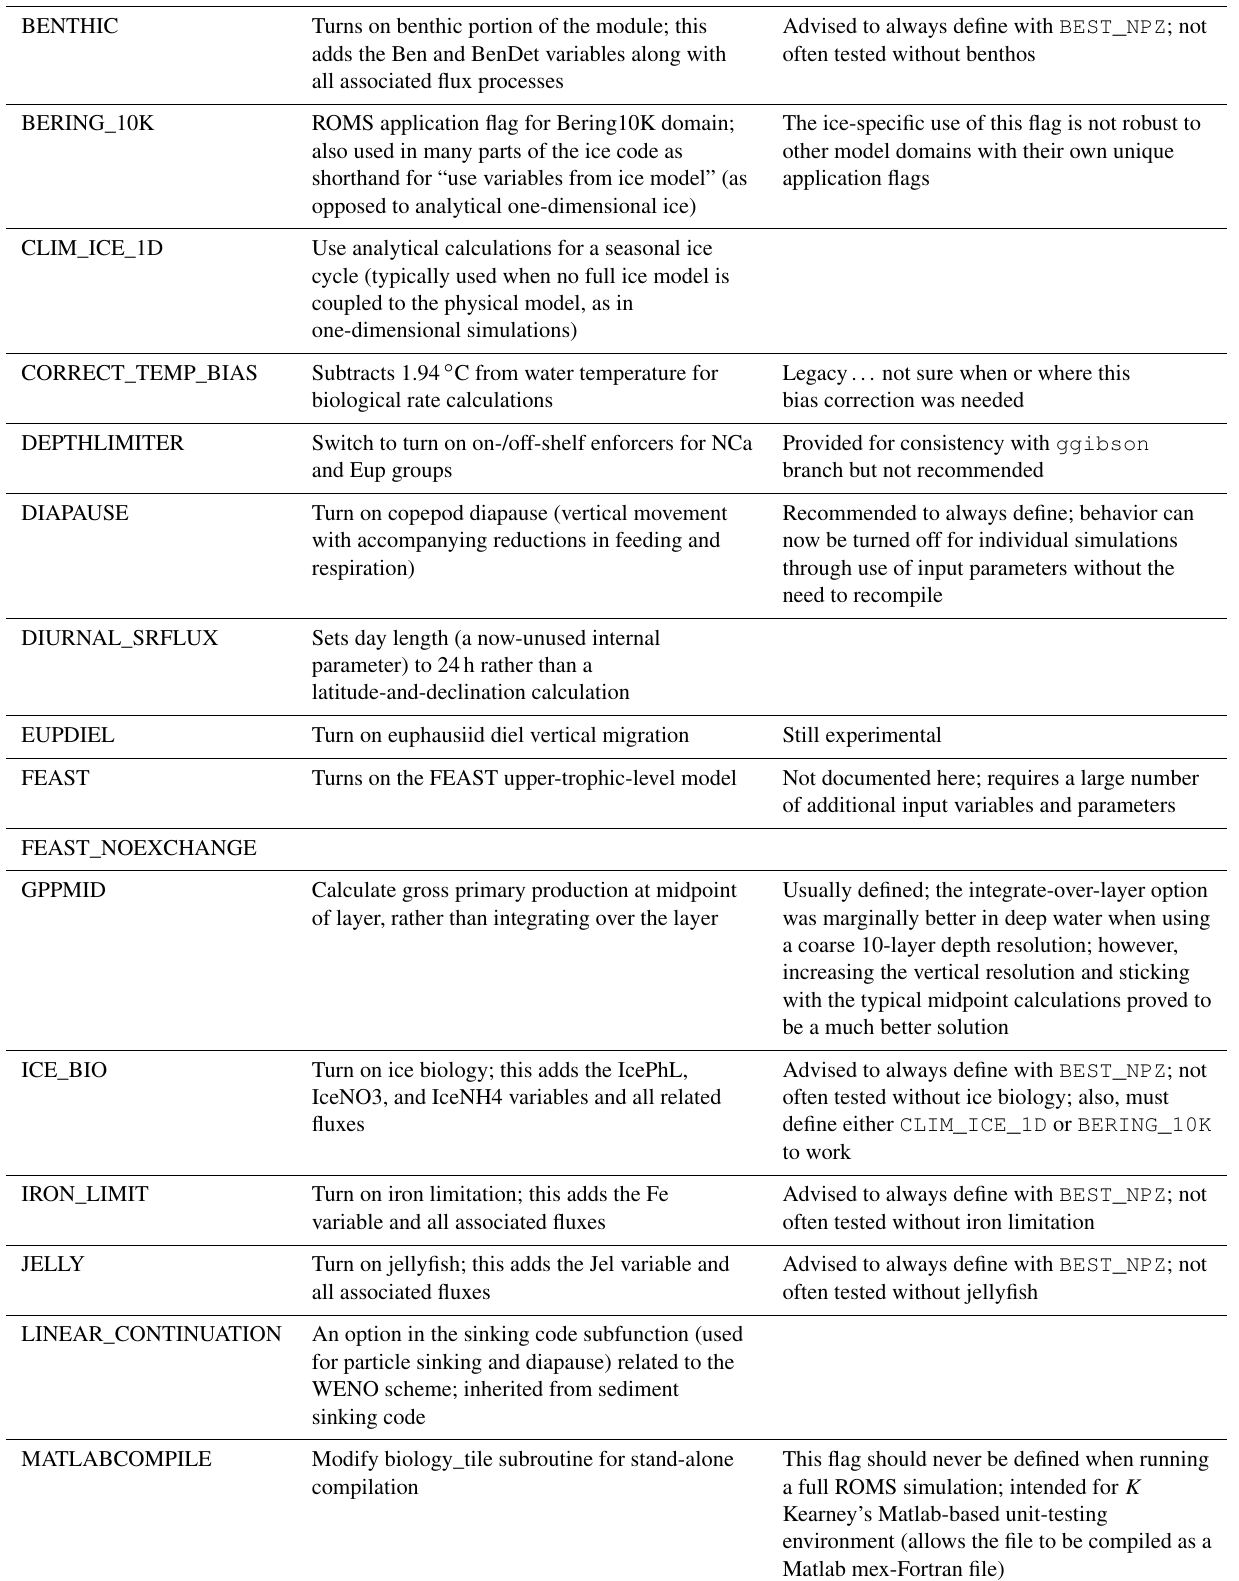
Table C1. Compilation flags related to the BEST_NPZ